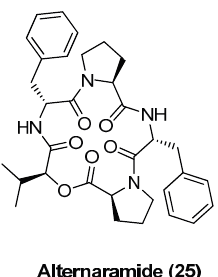
Figure 4. Structure of alternaramide ( 25 ).